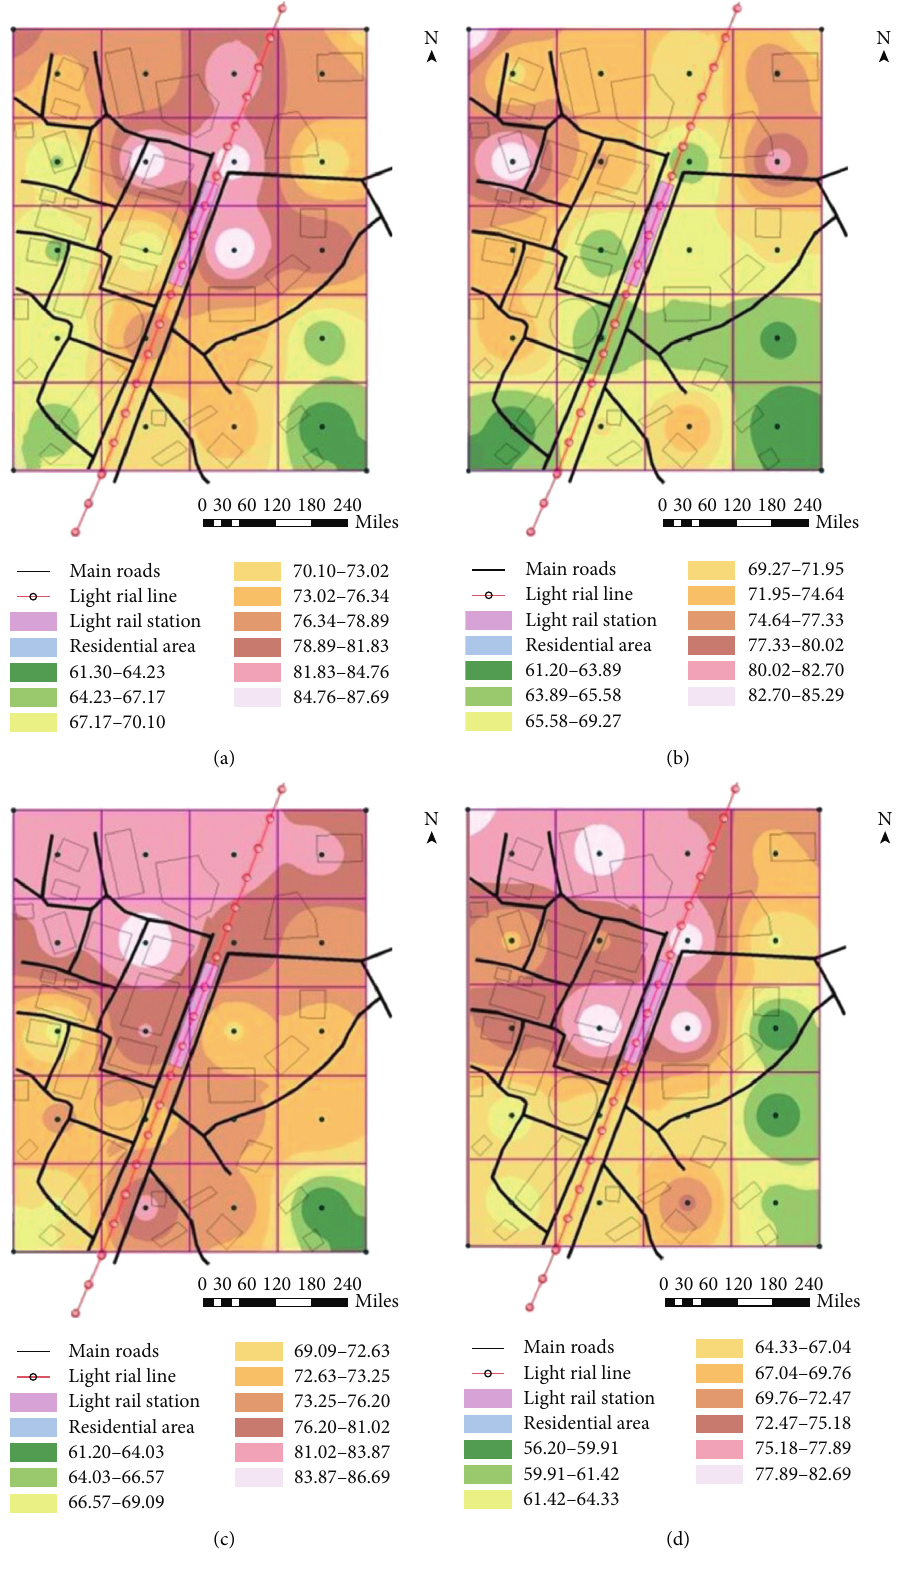
Figure 13: The acoustic environment for Friday. (a) 7:00 a.m. (b) 12:00 p.m. (c) 06:00 p.m. (d) 10:00